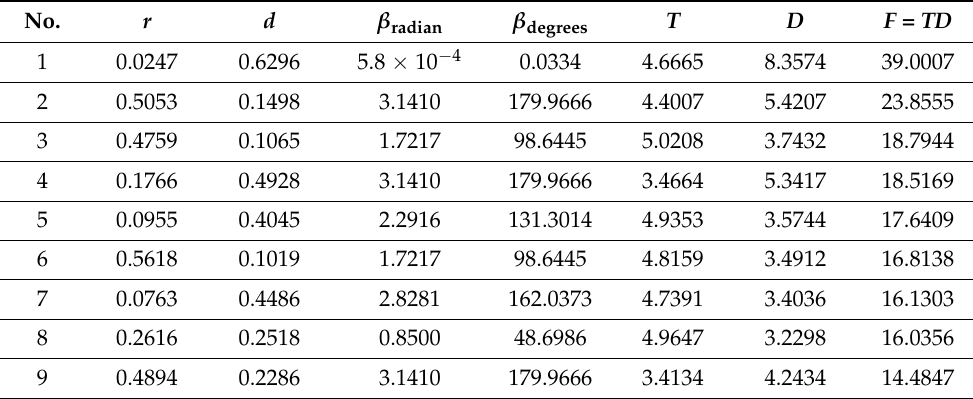
Table 1. Local maxima of the function 𝐹 = 𝑇𝐷 .